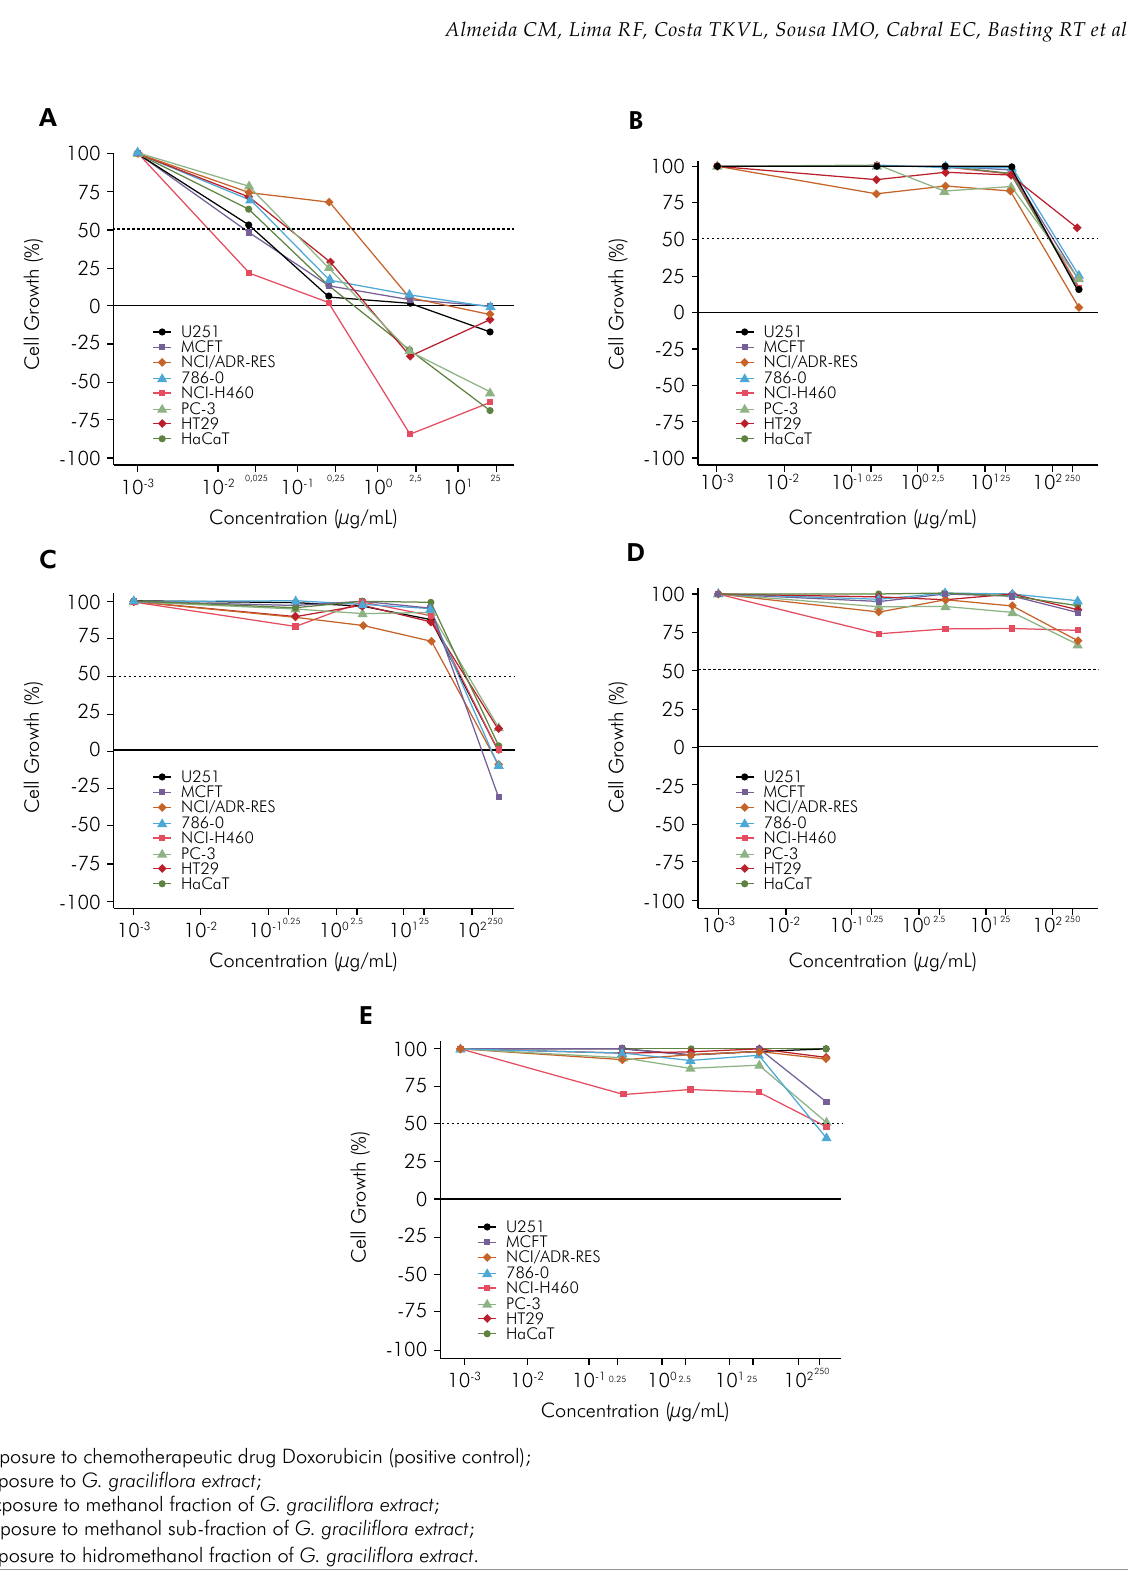
Figure 2. Proliferation of cell lines as a function of concentration (0.25, 2.5, 25 and 250 μ g/mL) after 48 hours according to